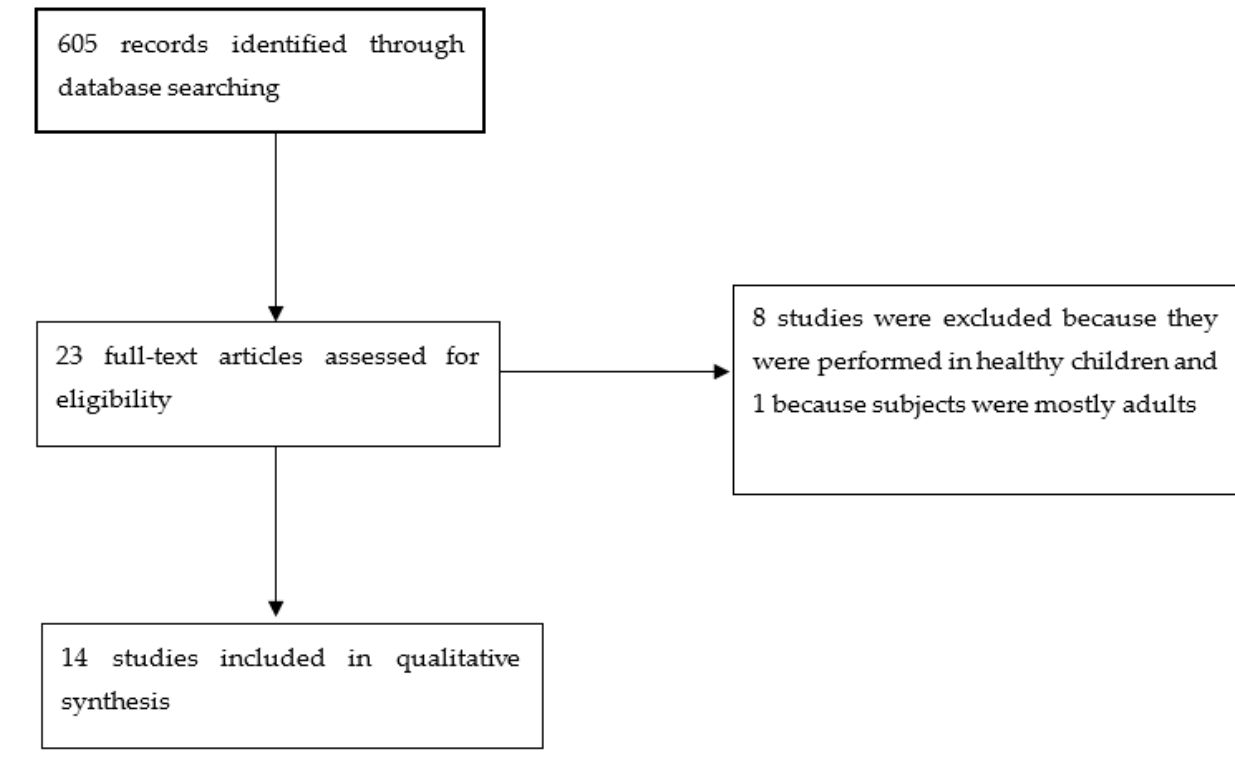
Figure 1. Flowchart of study selection.